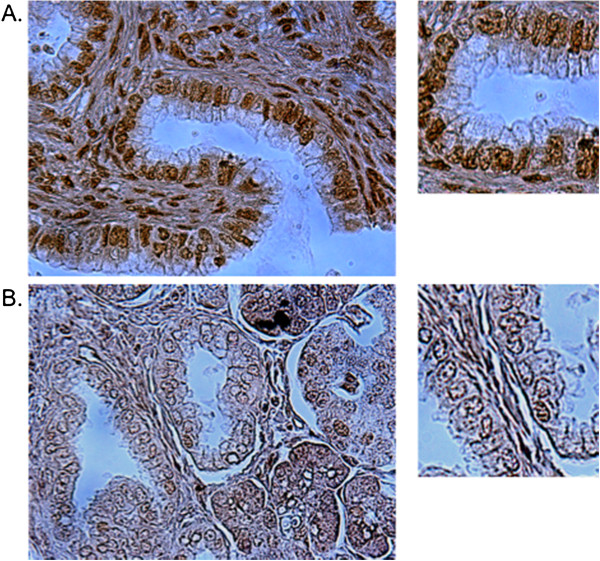
Representative immunohistochemistry staining for 53BP1 expression in pancreatic adenocarcinoma. (A) is high intensity of 53BP1 expression and (B) is low intensity of 53BP1 expression.